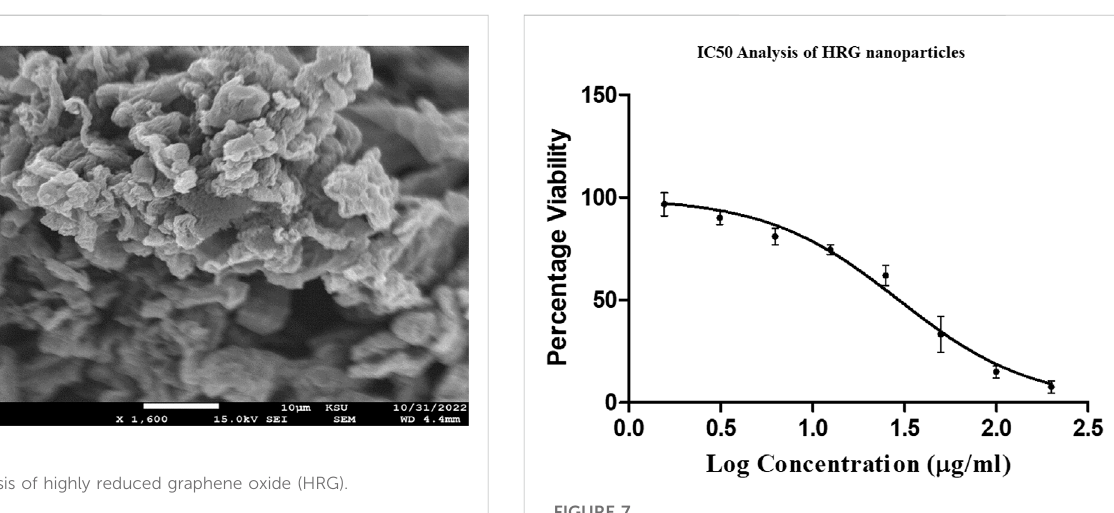
FIGURE 7 MTTassayshowingIC50valueof29 μ g/mLwithMCF-7celllines incubated for 24 h.